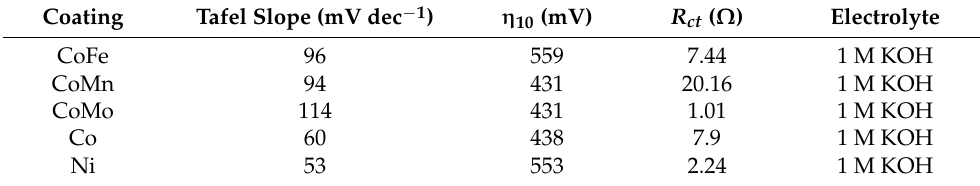
Figure 4. ( A ) Oxygen evolution reaction (OER) polarization curves (iR-corrected) of five studied coatings at 5 mV · s − 1 with ( B ) corresponding Tafel plots, ( C ) Nyquist plots at 1.67 V (amplitude of 5 mV in the 100 kHz–0.1 Hz range) with the corresponding Bode plots in the inset, and ( D ) chronoamperometric curves at 1.67 V for 1 h with the chronoamperometric curve of Co coating at the same potential for 24 h (inset). All measurements were done in 1 M KOH. Table 5. Electrochemical performance of the tested coatings toward OER in alkaline media.